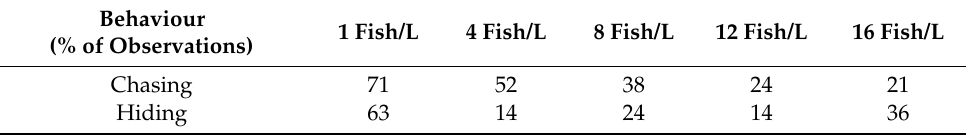
Table 1. Behavioural observations from the last week of the exposure period. Each tank in the setup was given a score, once per observation, corresponding to one if the behaviour was displayed or zero if the behaviour was absent. The results presented here show the average percentage during which a behaviour was displayed for tanks holding the same